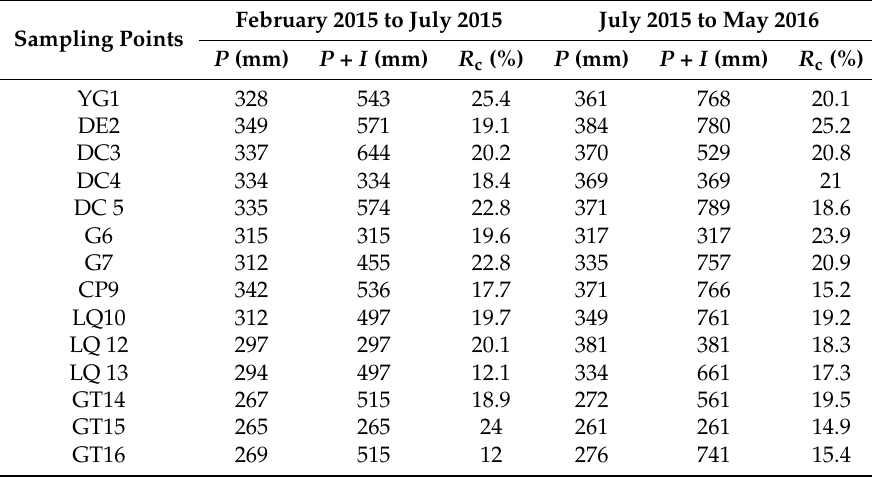
Table 5. The recharge coefficient of groundwater.